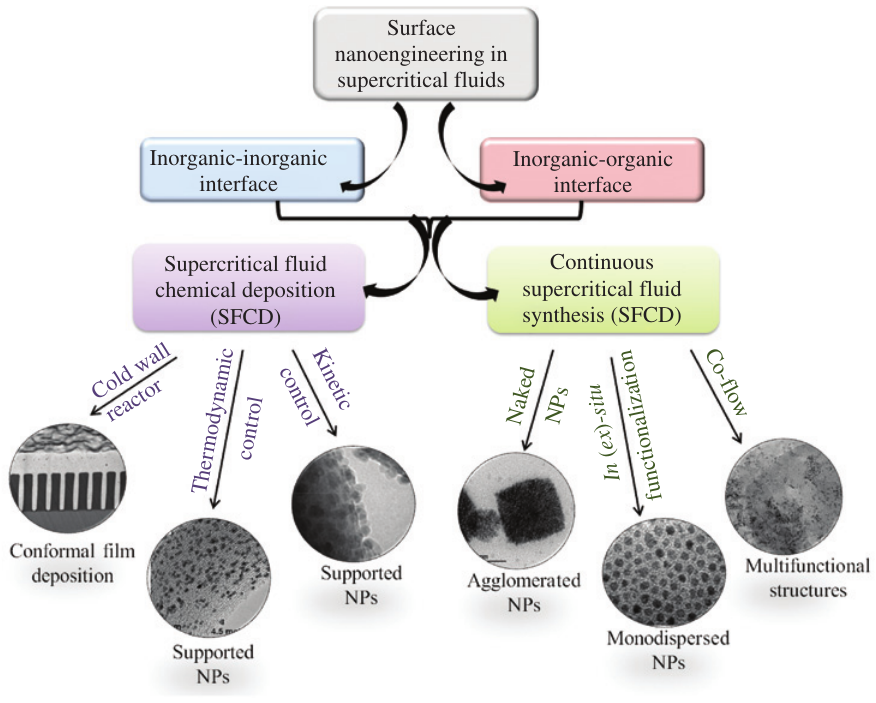
Figure 2: Sketch of the different concepts used in supercritical fluids technologies to build advanced inorganic or hybrid